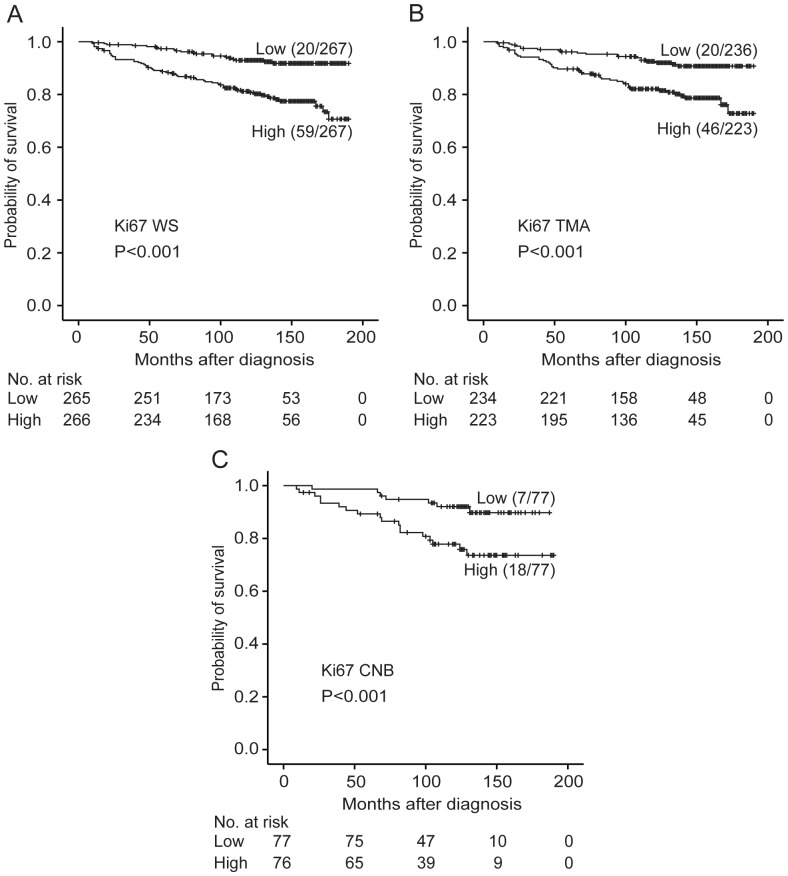
Breast cancer specific survival according to Ki67 expression.Survival curves (Kaplan-Meier) are shown for Ki67 expression on WS (A); TMA (B) and CNB (C). Cut-off points at the median were applied for all specimen categories. The number of events and total number of patients in each group are shown beside the description of each curve. Numbers at risk are presented below each curve.